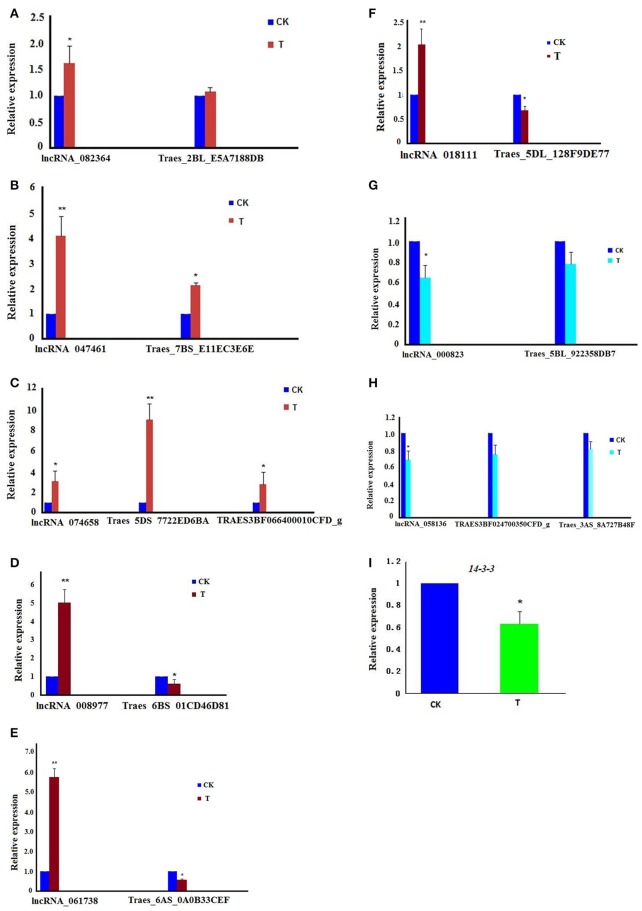
The relative expression of lncRNAs involved in the cell cycle and their target genes; the experiments of q-PCR and the data analyses were performed in three biological replicates. *Significant difference (p < 0.05); **Highly significant difference (p < 0.01). (A) The chart shows that both lncRNA_082364 and its target gene, Traes_2BL_E5A7188DB, were up-regulated. (B) The chart shows that both lncRNA_047461 and its target gene, Traes_7BS_E11EC3E6E, were up-regulated. (C) The chart shows that lncRNA_074658 and its target genes, Traes_5DS_7722ED6BA and TRAES3BF066400010CFD_g, were up-regulated. (D) The chart shows that lncRNA_008977 was up-regulated, but its target gene, Traes_6BS_01CD46D81, was down-regulated. (E) The chart shows that lncRNA_061738 was up-regulated, but its target gene, Traes_6AS_0A0B33CEF was down-regulated. (F) The chart shows that lncRNA_018111 was up-regulated, but its target gene, Traes_5DL_128F9DE77 was down-regulated. (G) The chart shows that both lncRNA_000823 and its target gene, Traes_5BL_922358DB7, were down-regulated; (H) The chart shows that lncRNA_058136 was down-regulated, and its target genes, TRAES3BF024700350CFD_g and Traes_3AS_8A727B48F, were down-regulated. (I) The chart shows that the 14-3-3 gene was down-regulated.